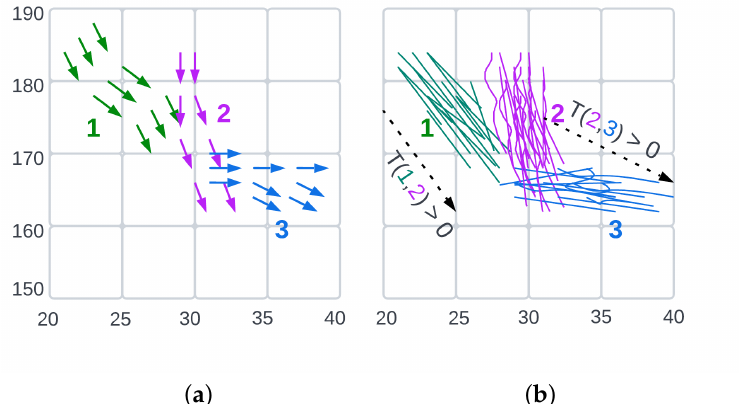
Figure 2. An example of motion primitives learnt using ASNSC [9,20]. ( a ) Three sample motion primitives from the learned dictionary presented in discretized grid, each motion primitive d k is shown in different color. ( b ) Shows a number of training sample trajectories which have been segmented into three clusters using their similarity with the motion primitives given in ( a ). The black arrows signify the transition from cluster i to cluster j based on the Transition matrix T when their respective entry in non-zero, i.e., T ( m , n ) > 0. The x and y axis are in